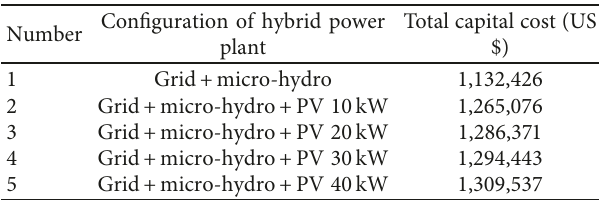
Figure 18: The design of the power inverter in Homer software. Table 3: Total capital costs for various configurations of the hybrid solar photovoltaic and micro-hydro